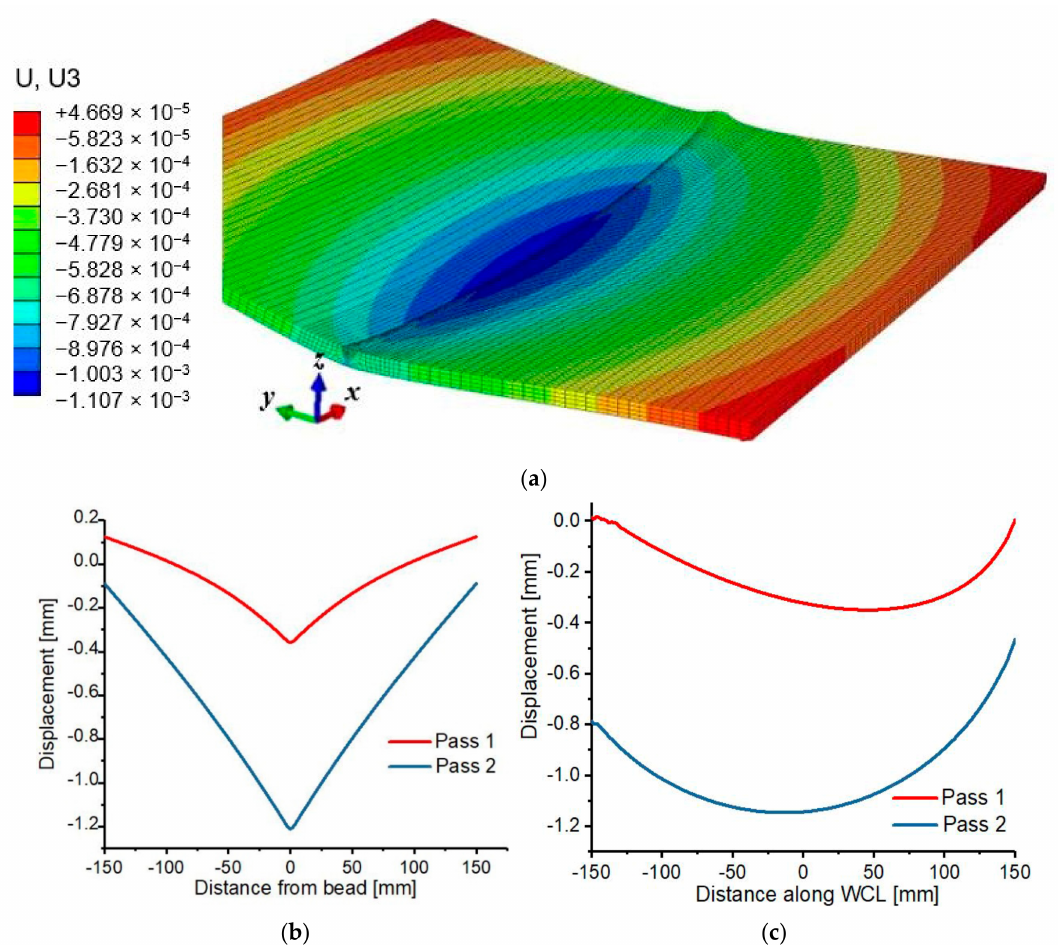
Figure 19. ( a ) FE welding distortion ( b ) Transverse distortion ( c ) Longitudinal